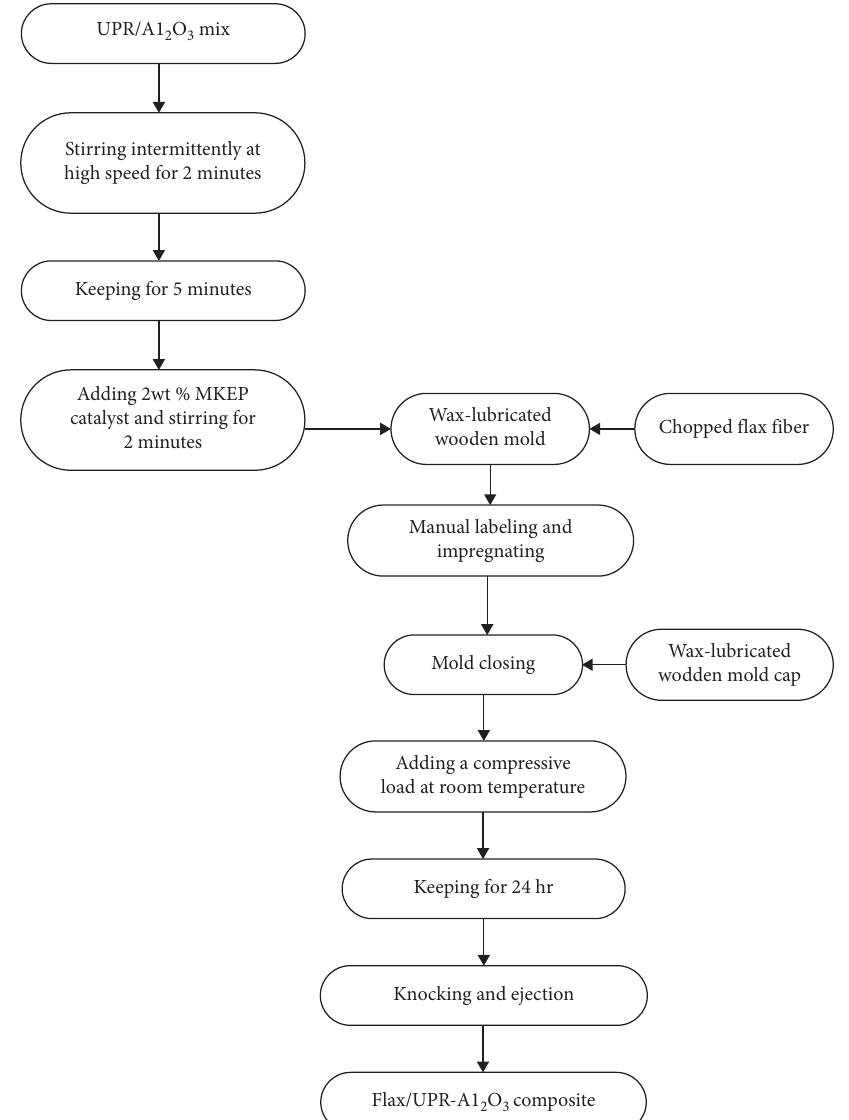
Figure 1: Composite processing flow